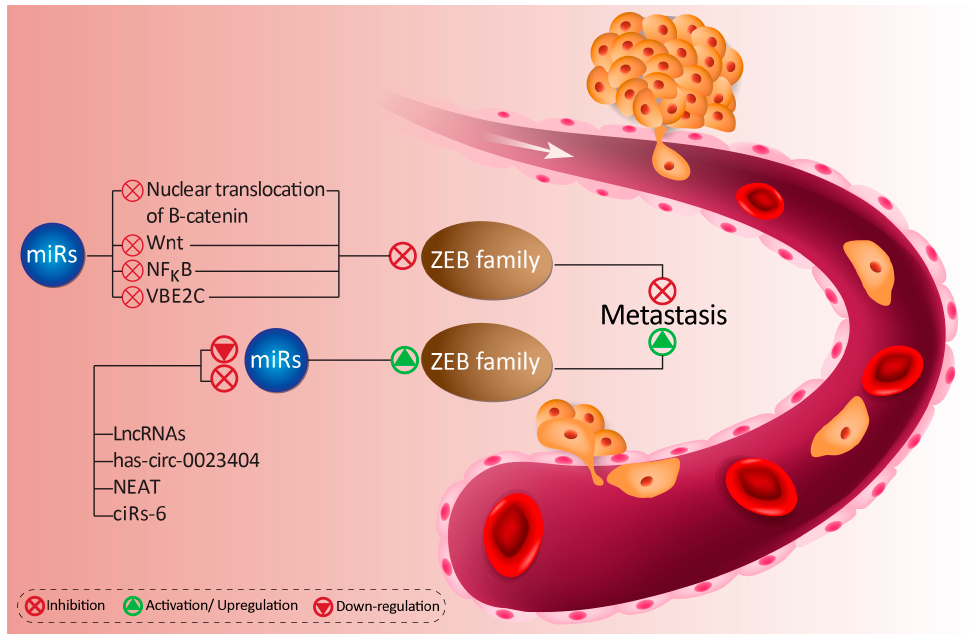
Figure 1. The oncogenic upstream mediators of miRs activating ZEB proteins, which enhances metastasis and migration of cancer cells.